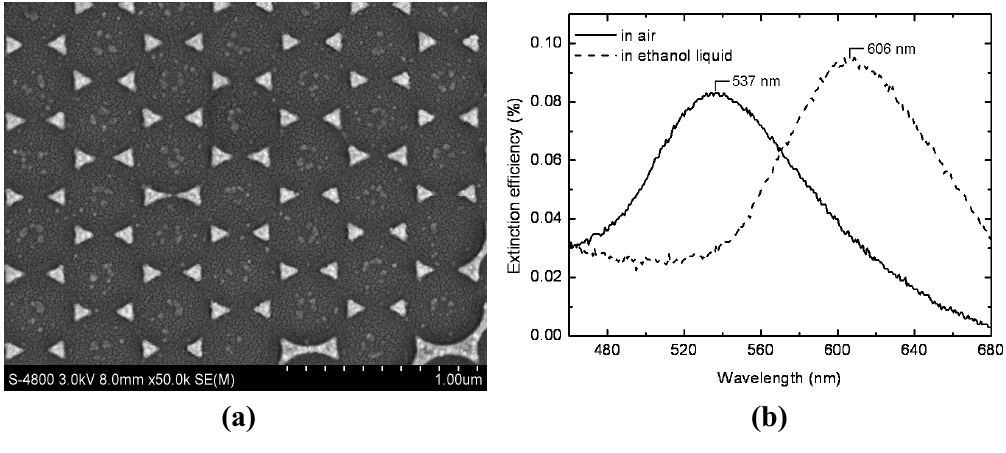
Figure 2. (a) SEM image of the fabricated triangular nanoprisms. (b) The test LSPR spectra in clean air and in liquid phase ethanol.